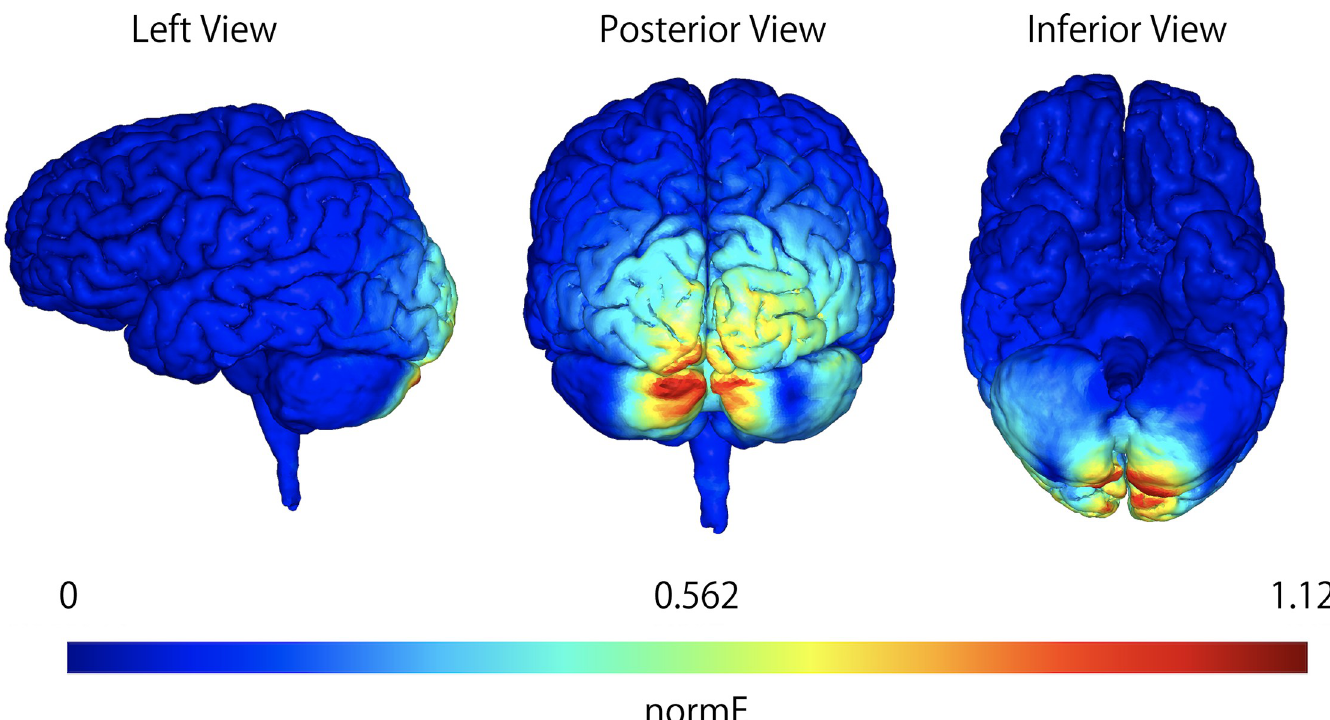
Fig 2. Simulation of the electric field induced by TMS. Electric field induced by TMS using butterfly coils in the coronal, sagittal, and horizontal views. The scale represents normE which is the magnitude of the electric field (V/m) induced by the TMS over the site at 1 cm below the inion. The affected sites are cerebellar structures. TMS: transcranial magnetic